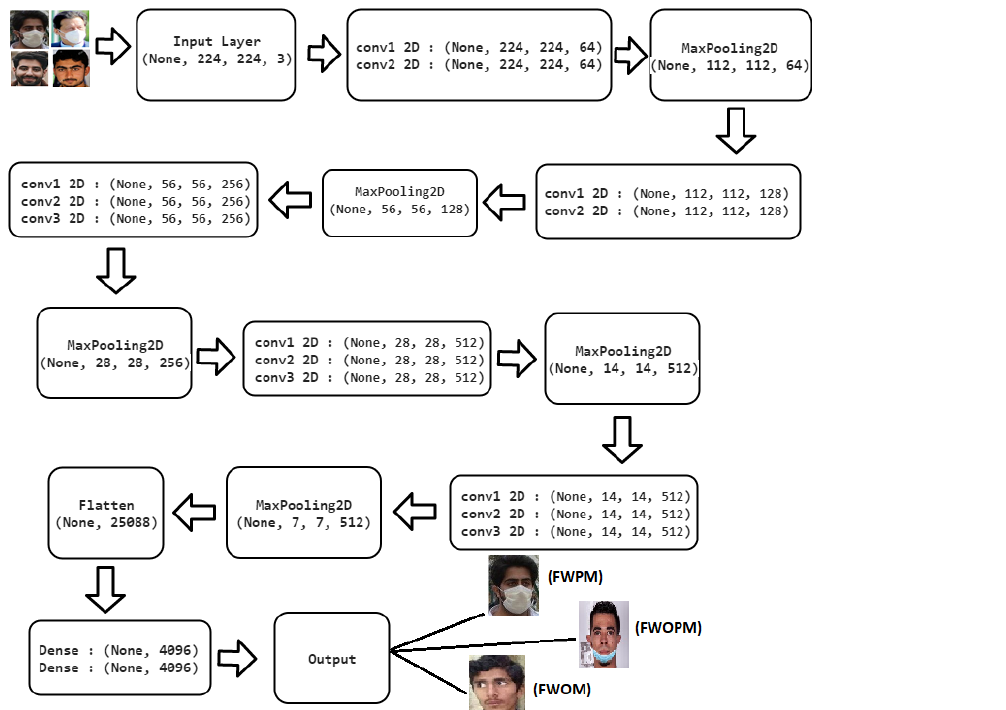
Figure 11. Fine-tuned model